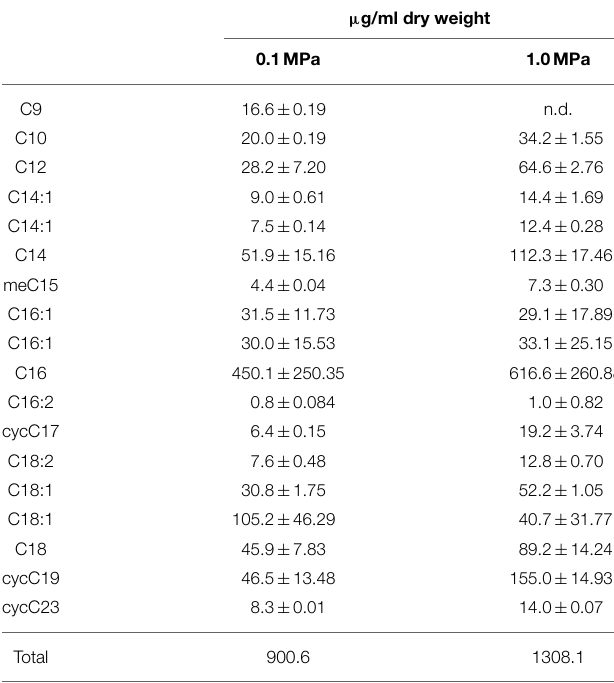
TABLE 2 | CG-1 fatty acid content at 0.1 and 1.0MPa CO 2 .